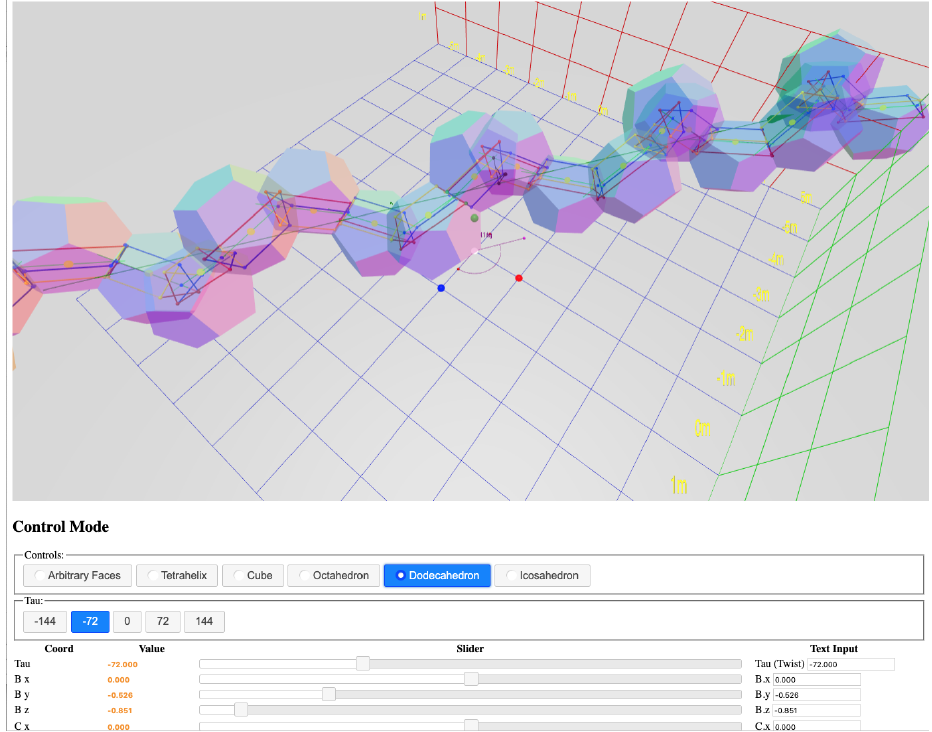
Figure 1. Example Segmented Helix Generated From the